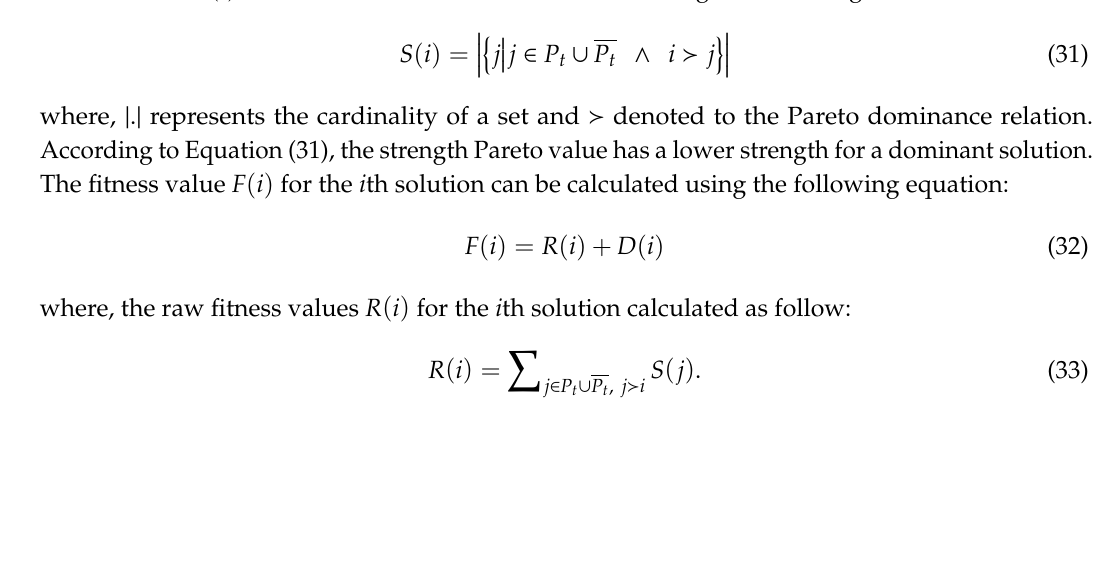
Figure 3. Strength Pareto evolutionary algorithm II (SPEA II) algorithm flowchart.